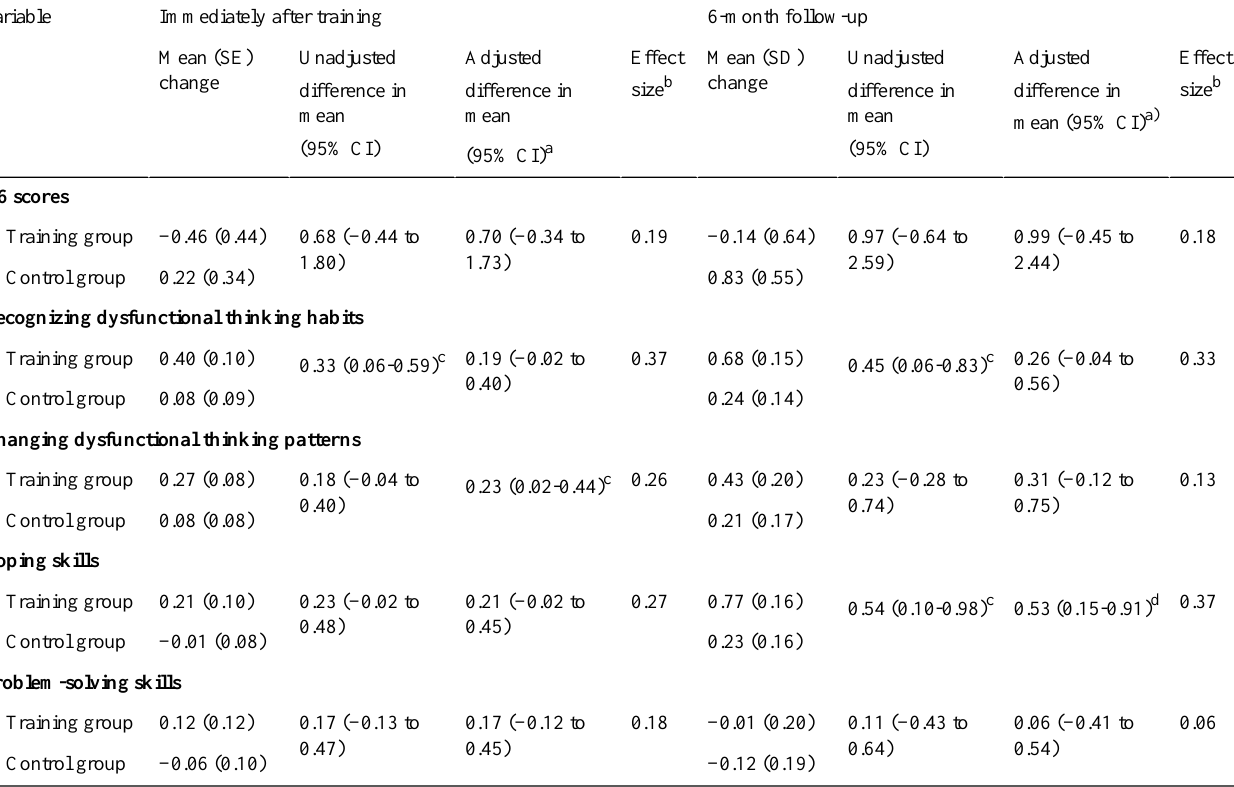
Table 2. Intention-to-treat analyses of primary and secondary outcomes after training and 6-month follow up.